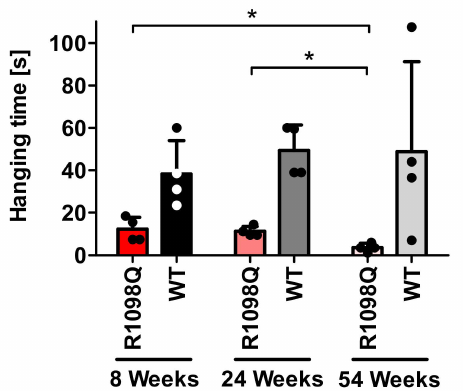
Figure 3. Hanging wire test The graph depicts the difference in hanging time between the R1098Q and WT mice. The 8-week-old group (WT, n = 4; R1098Q, n = 4)), the 24-week-old group (WT, n = 4; R1098Q, n = 4), and the 54-week-old group (WT, n = 4; R1098Q, n = 4). There were 2 females and 2 males in each group. The dots represent the mean hanging time on the wire. Error bars represent standard deviations (SD). The statistics were calculated using the Mann–Whitney test. Statistically significant differences between R1098Q mice at different ages indicating the progression of the phenotype are marked with asterisks. (* p <